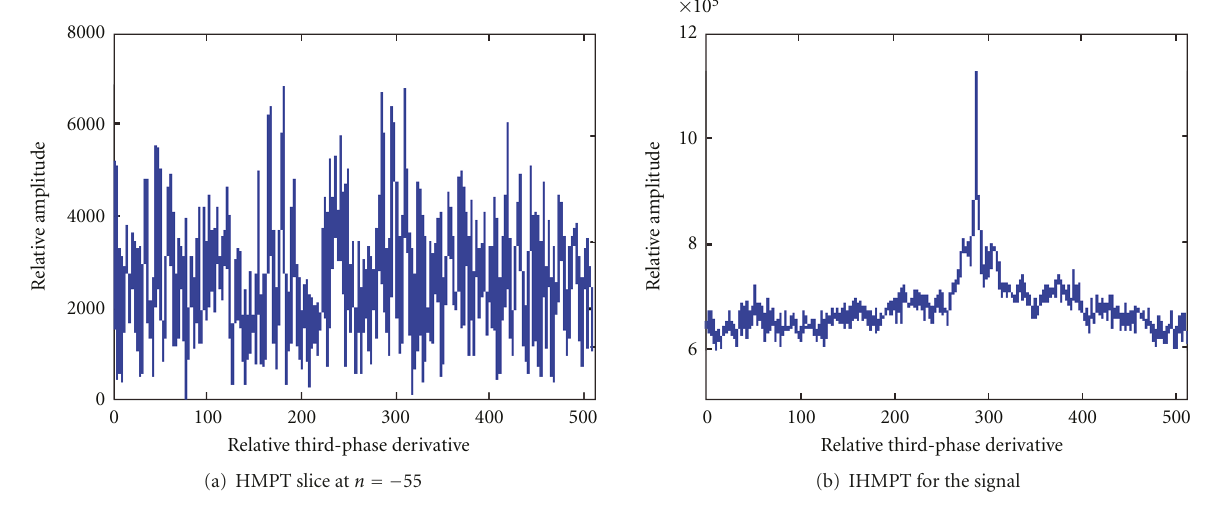
Figure 2: Results of the numerical